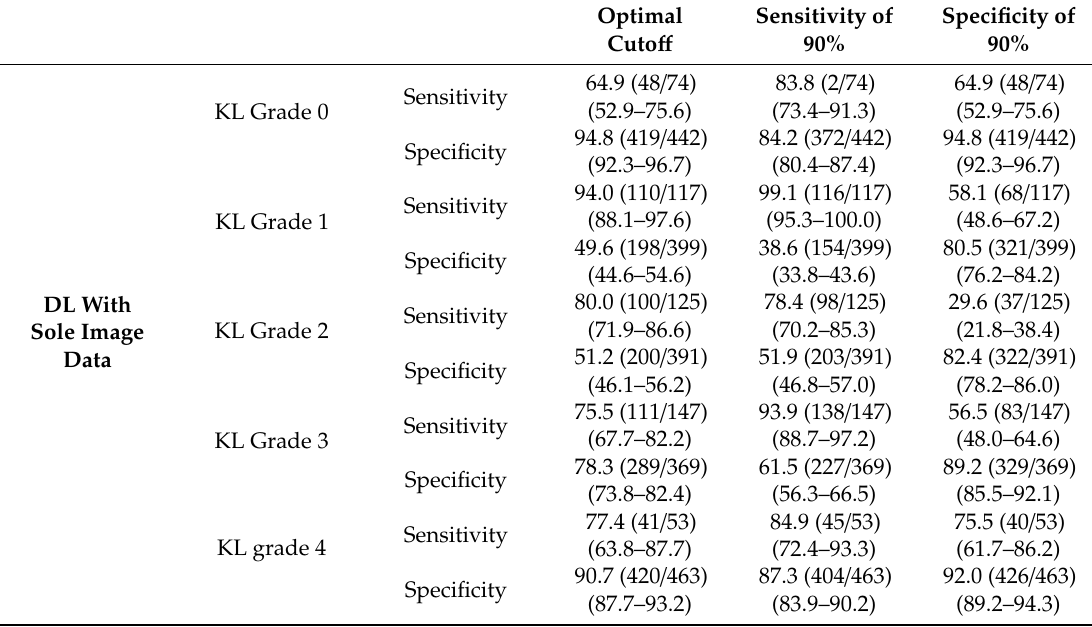
Table 3. Diagnostic performance of DL